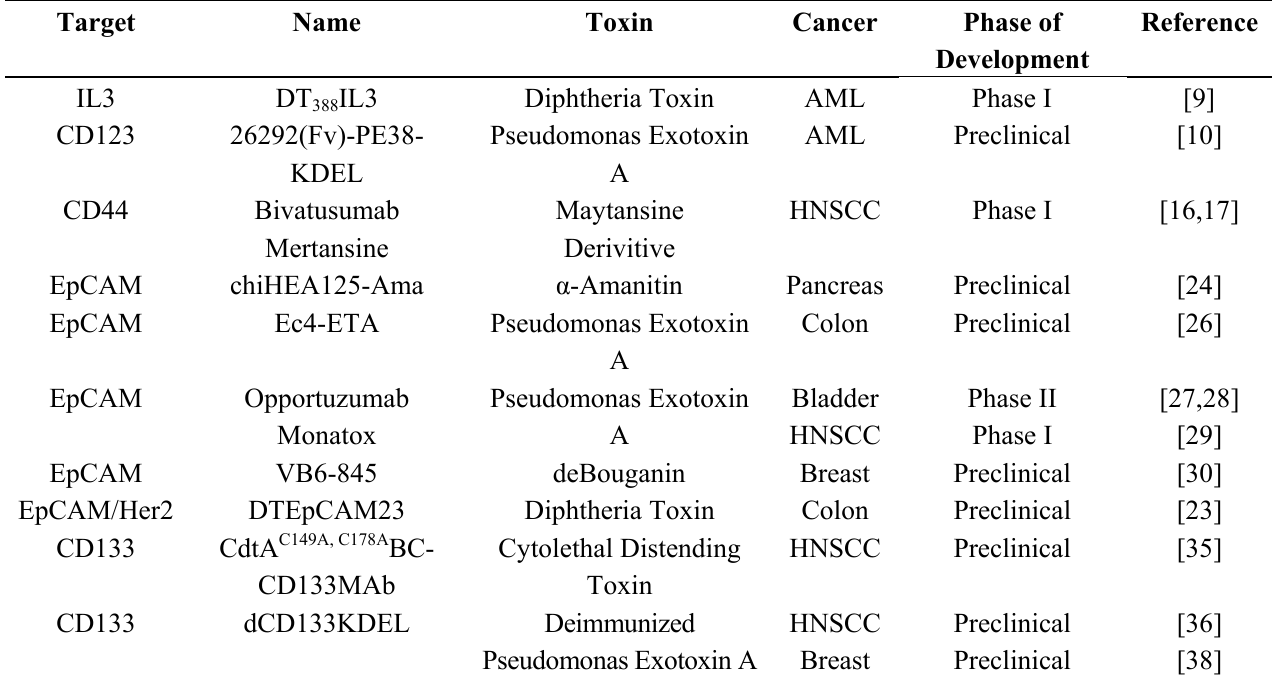
Table 1. Targeted Toxins directed against CSC markers currently under